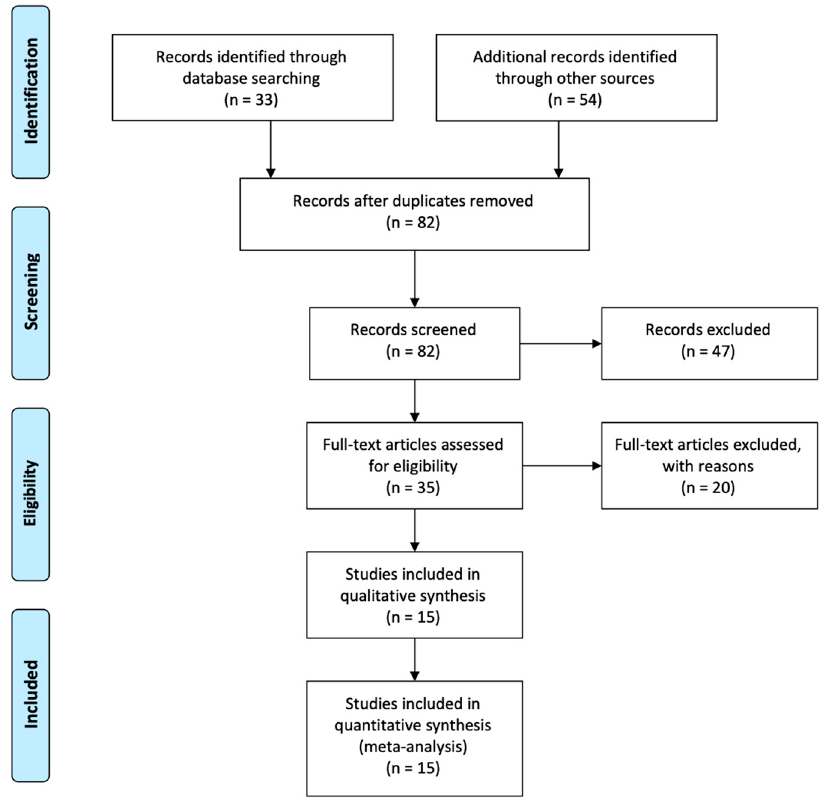
Figure 2. Flow diagram of the selection of the Figure 2 . Flow diagram of the selection of the papers.